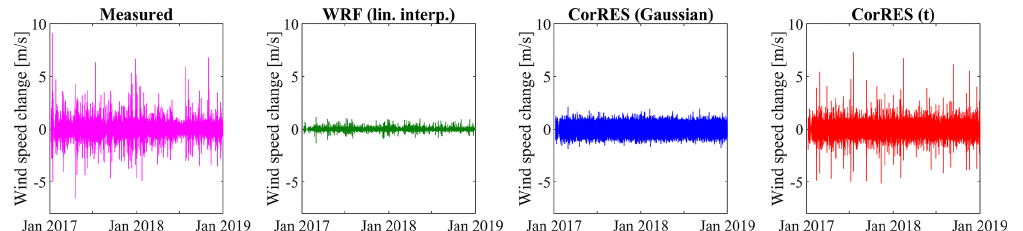
Figure 6. Wind speed fluctuations in 10min: measured, WRF, WRF with Gaussian fluctuations (CorRES(Gaussian)), and WRF with Student t Gaussian copula fluctuations (CorRES( t )).